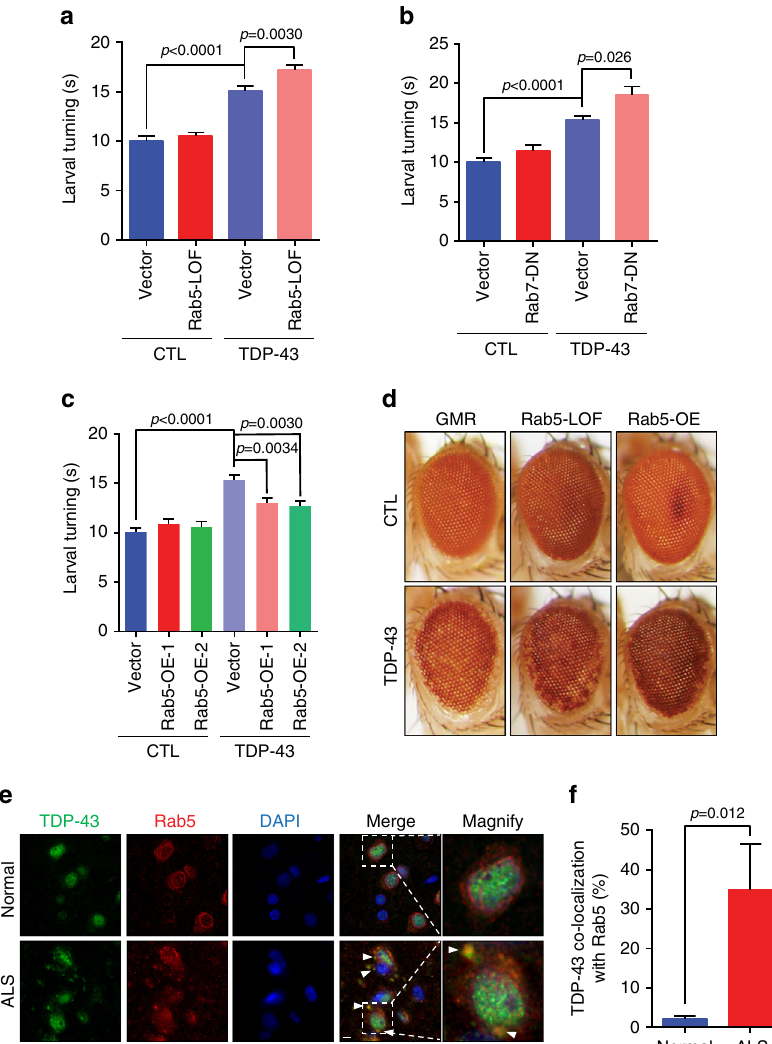
Fig. 7 TDP-43-induced locomotor dysfunction and neurodegeneration is modulated by key endocytic proteins. a – c TDP-43 was speci fi cally expressed in motor neurons +/ − distinct Rab mutant backgrounds, and larval turning times (locomotor dysfunction) assessed. a Rab5 loss of function (LOF), b Rab7 dominant negative (DN), c two independent Rab5 overexpression (OE) lines. Signi fi cance was assessed by two tailed Student ’ s t test. Data are shown